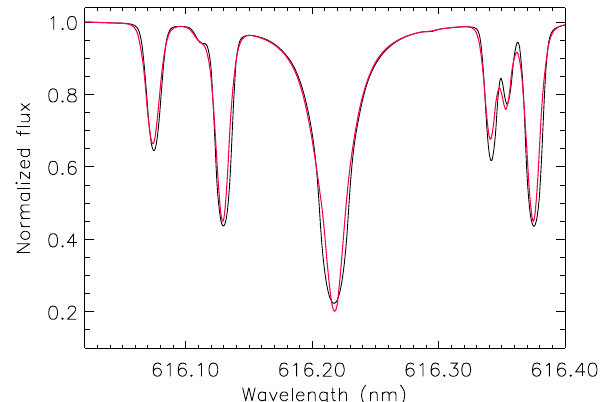
Fig. 3 Spectra in the vicinity of the Ca i λ 616 . 2nm line computed for a solar-like star using a classical hydrostatic model ( black ) and a CO5BOLD hydrodynamical simulation ( red ; see Tremblay et al.